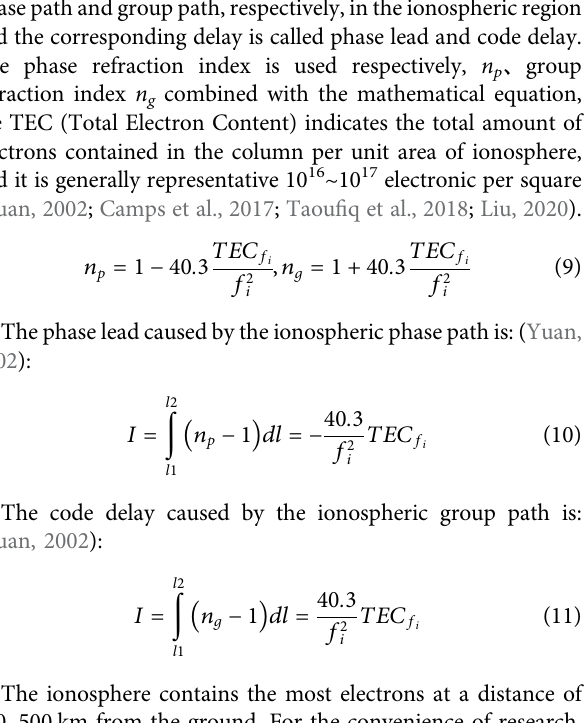
Frontiers in Earth Science |